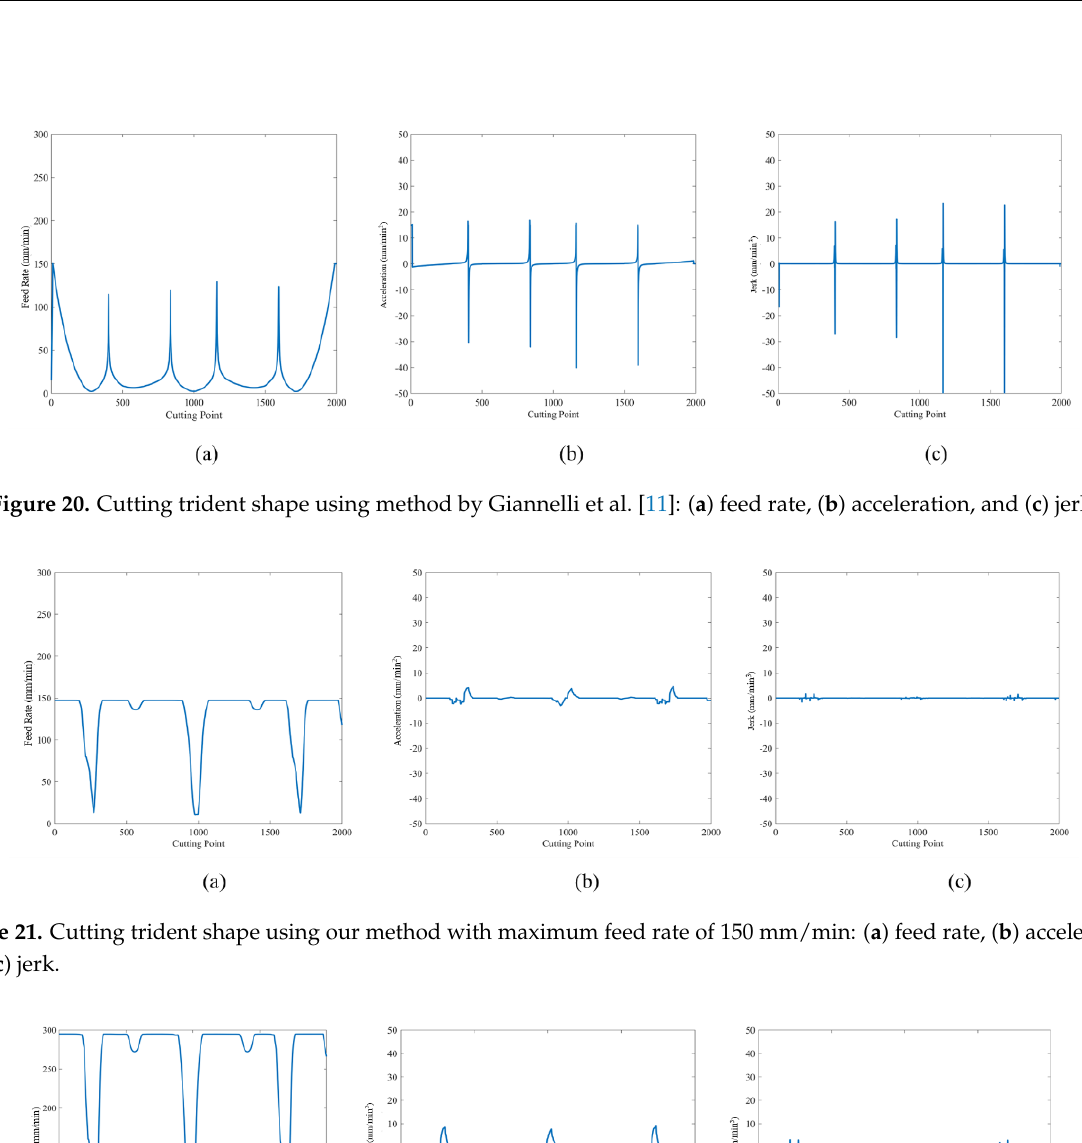
Figure 19. Cutting trident shape using method by Yeh and Hsu [10]: ( a ) feed rate, ( b ) acceleration, and ( c ) jerk.